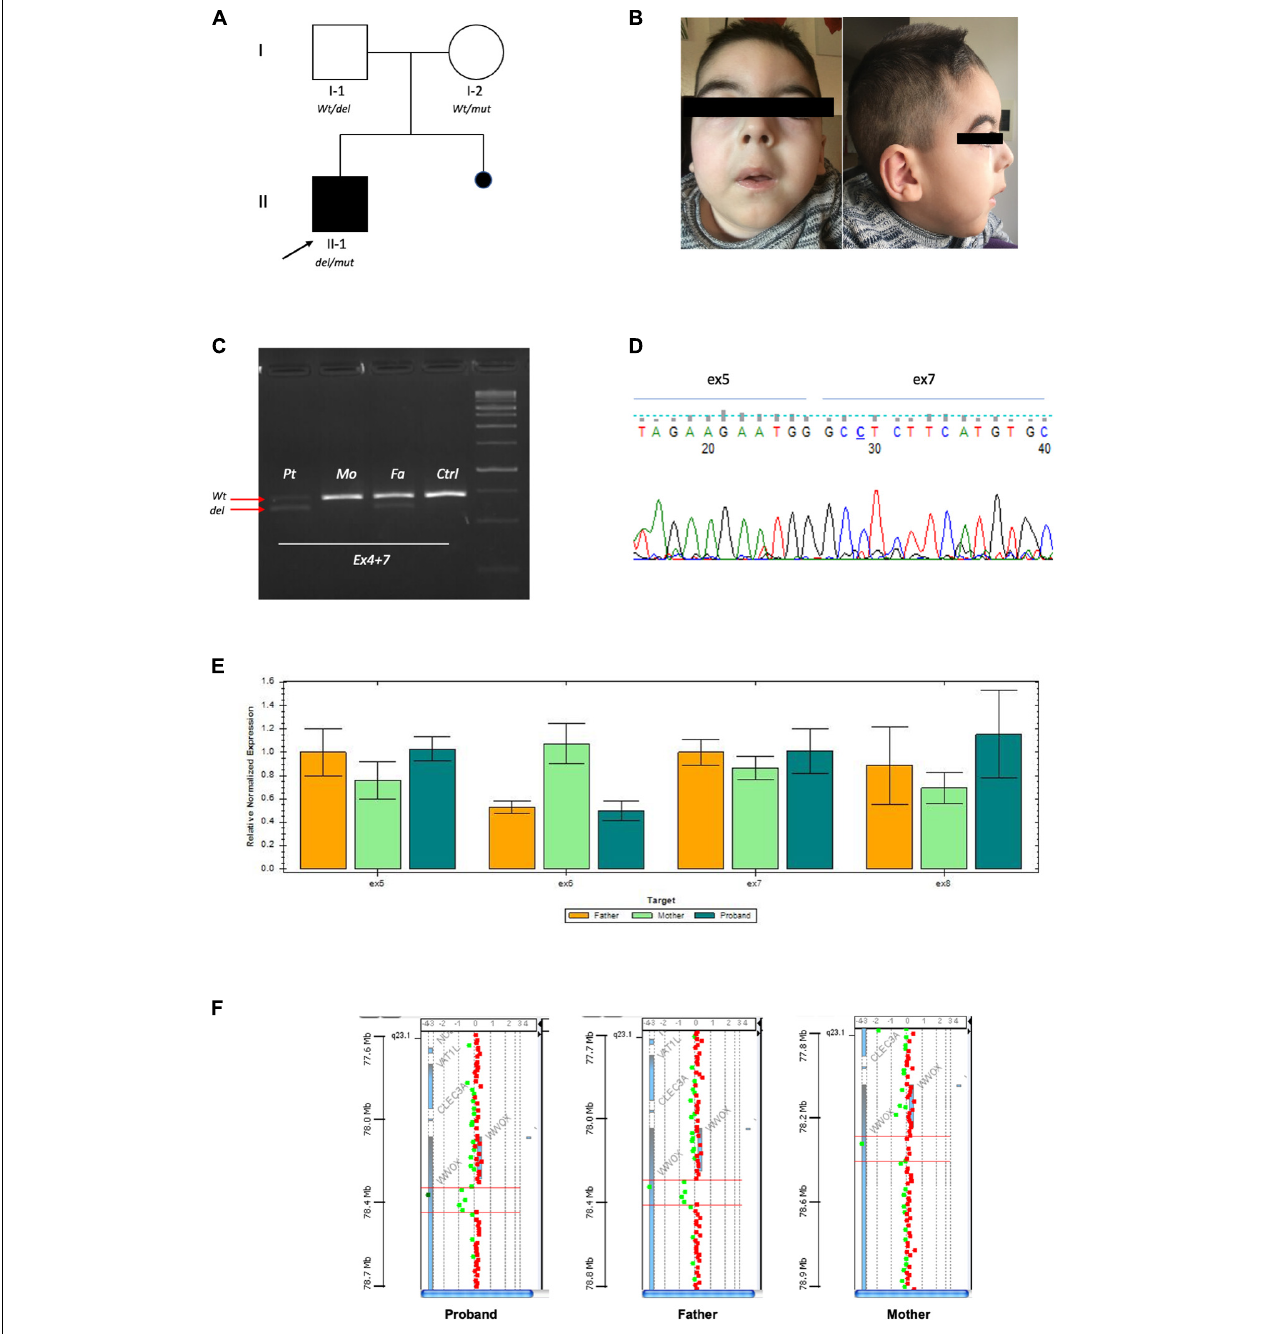
FIGURE 1 | (A) Pedigree of family: Full square mutated affected case. Empty circle and square unaffected parents. (B) Portraits of patient II-1 at 4 years. (C) RT-PCR by fibroblasts showing that the proband and his father had the same product pattern. Arrows indicate the Wt product and deleted one. (D) Sanger of the deleted fragment showing fusion of exon 5 and 7. (E) Confirmative qPCR on DNA validating exon 6 deletions with loss of 50% product in the proband and carrier father. (F) High resolution array-CGH 180K highlighting genomic deletion of the proband and father.